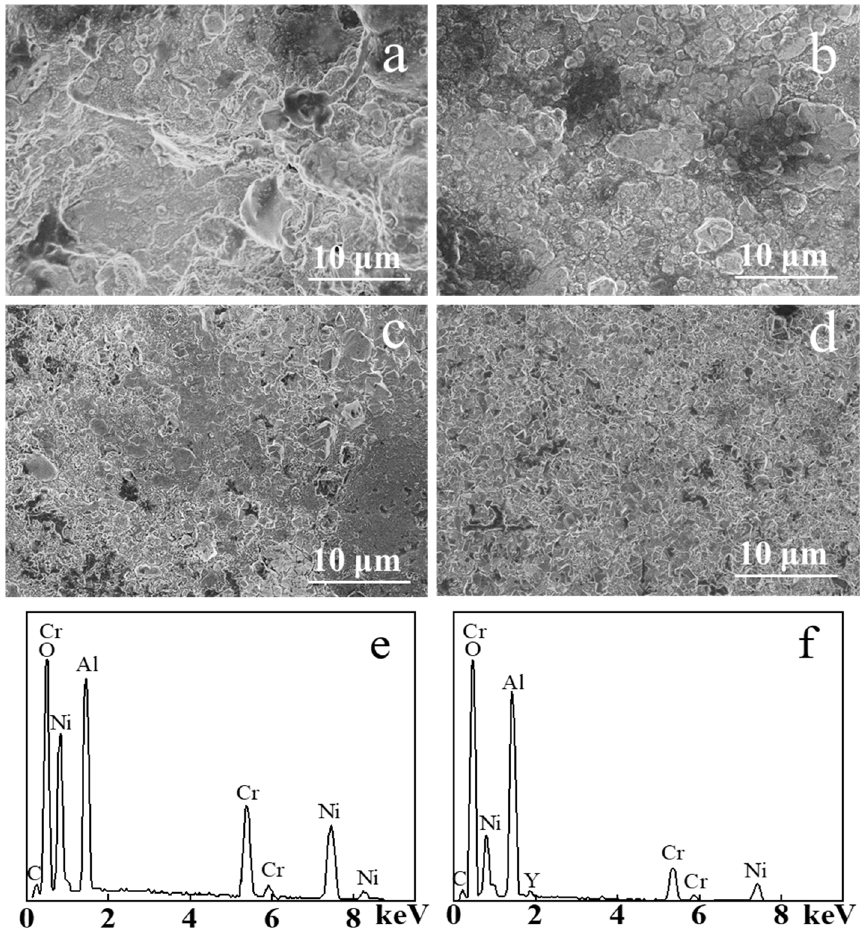
Figure 5. SEM images of the NiCrAlY coating surface morphology before and after a high-current pulsed electron beam irradiation after static oxidation at 900 ℃ for 100 h: ( a ) nonirradiated, ( b ) 12 J/cm 2 , ( c ) 15 J/cm 2 , ( d ) 18 J/cm 2 , ( e – f ) the EDS results of ( a ) and ( d ), respectively.